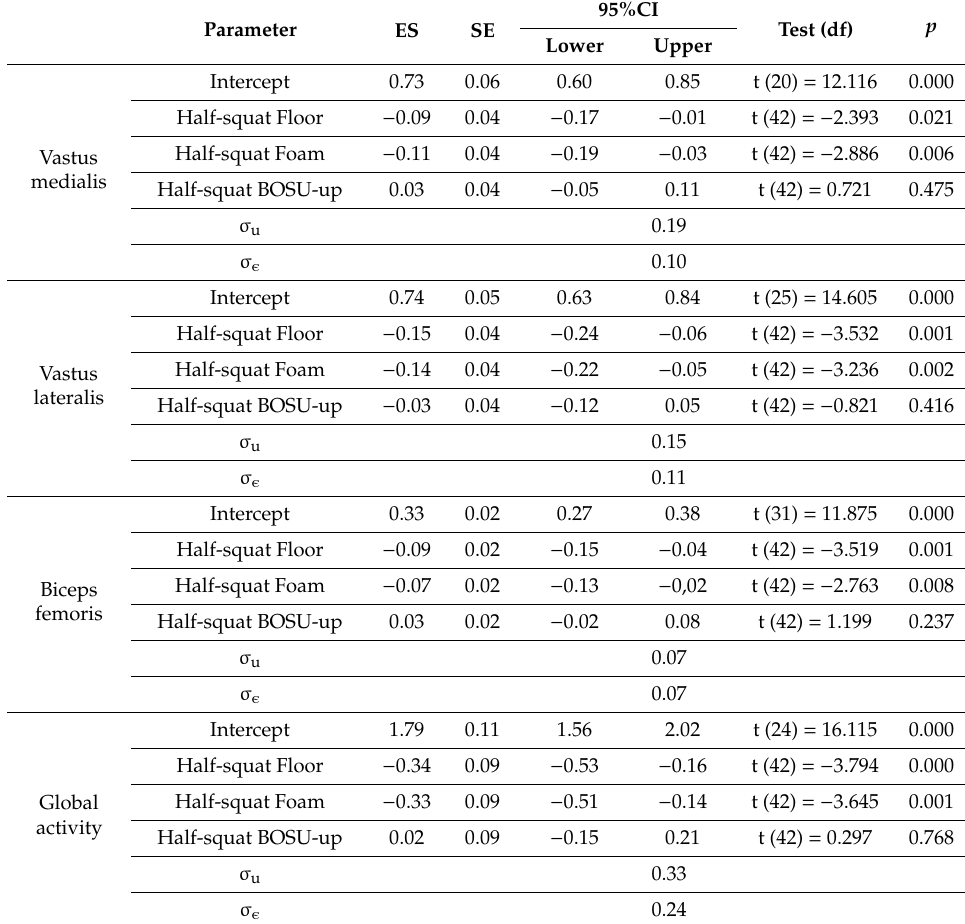
Table 3. Linear mixed model with exercise condition as the fixed e ff ects and muscle activity (vastus medialis, vastus lateralis, biceps femoris, and global activity) as the dependent variable.